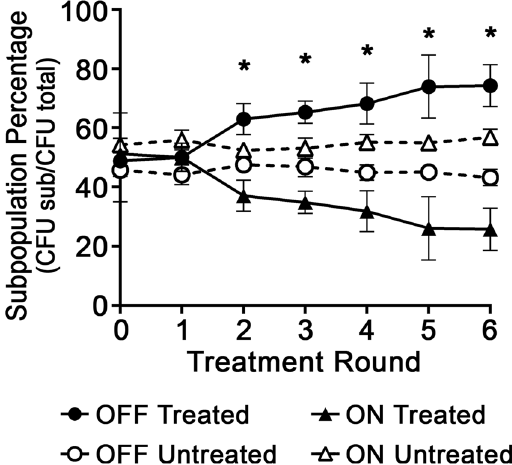
Figure 2. The modA2 locked OFF subpopulation was selected for during repeated exposure to oxidative stress induced by H 2 O 2 . A mixed culture that contained an equal number of modA2 locked ON:GFP and modA2 locked OFF:mCherry was subjected to six rounds of H 2 O 2 exposure. Selection for modA2 locked OFF was apparent after 2 rounds of stress, whereas after 6 rounds, the modA2 locked OFF subpopulation comprised 75% of the total population (solid markers). The percentages of each subpopulation were significantly different at rounds 2 to 6, P < 0.01, unpaired t-test. There was no significant difference between the percentages of each population at any time point for untreated populations (hollow markers), unpaired t-test. Exogenous H 2 O 2 selected for the modA2 OFF status over the modA2 ON